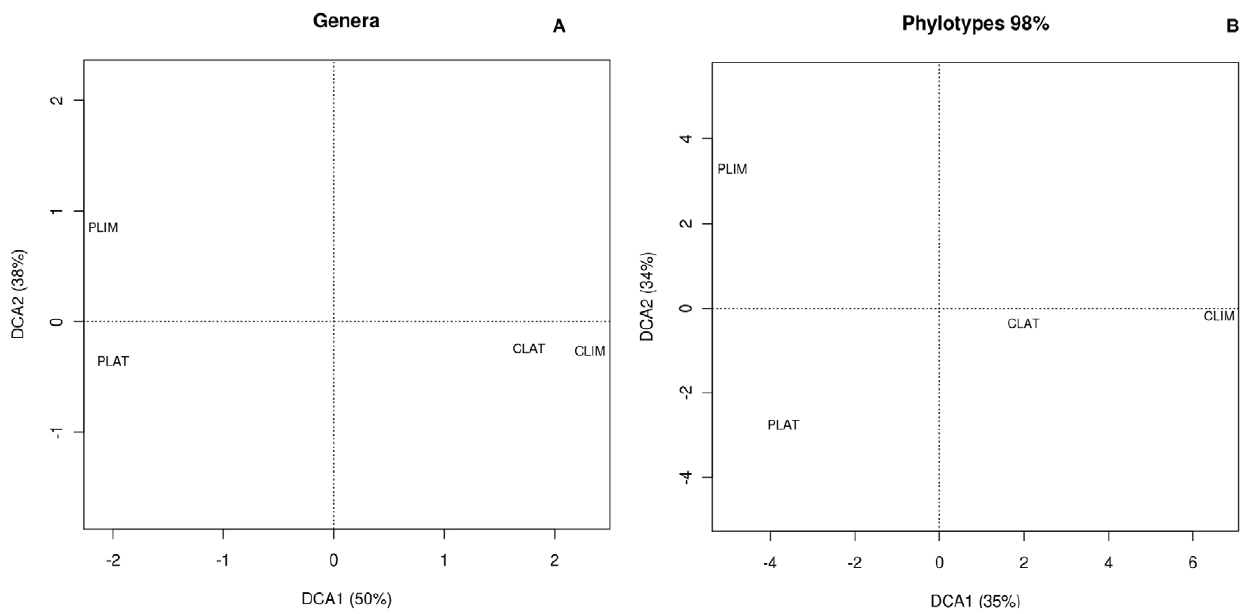
Figure 3. Detrended correspondence analysis based on a) genus and b) phylotype distributions. CLAT, C. latum larvae; CLIM, C. limbipenne larvae; PLAT, C. latum cactus medium; PLIM, C. limbipenne cactus medium.